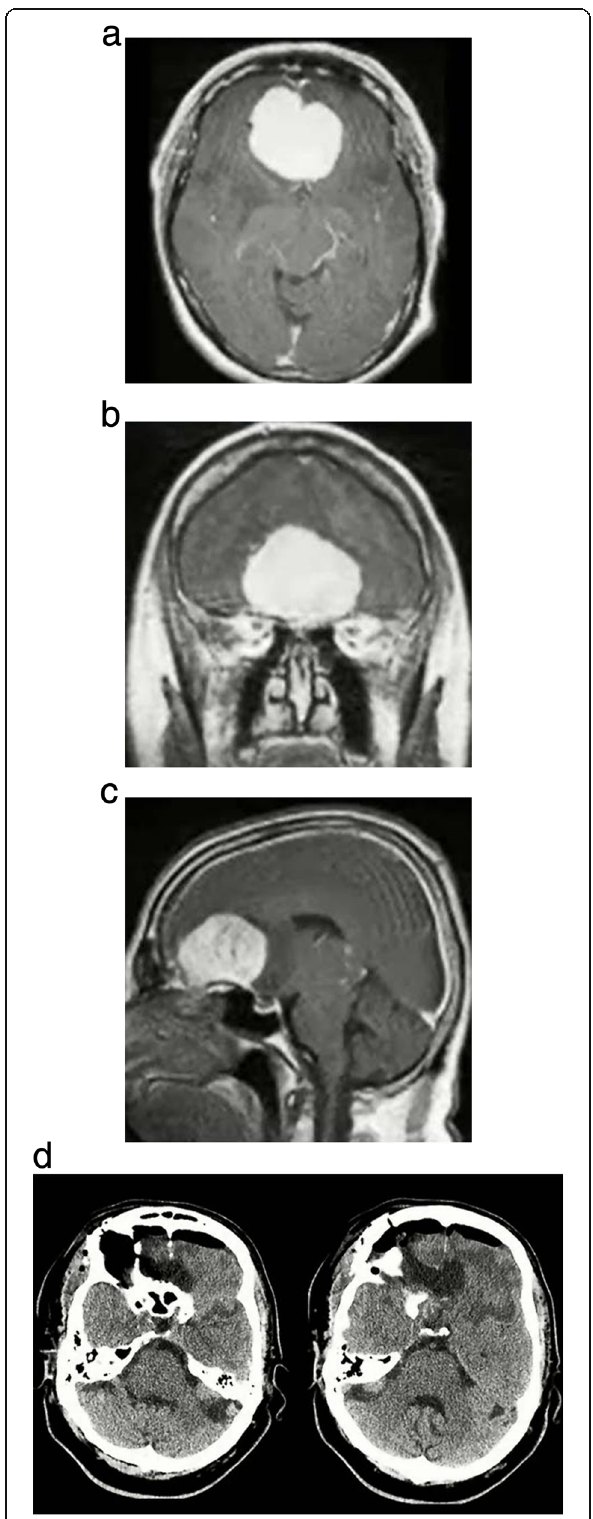
Fig. 5 A case of olfactory groove meningioma successfully operated on through right-side lateral supraorbital approach. Preoperative axial ( a ), coronal ( b ), and sagittal ( c ) MRI views show olfactory groove meningioma. Postoperative CT axial view ( d ) shows complete removal of the meningioma